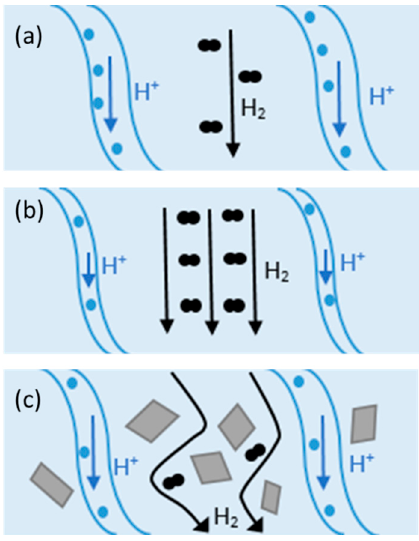
Figure 3. ( a ) Hydrogen and proton transport through Nafion at 80 °C ( b ) Hydrogen and proton transport through Nafion at higher temperatures ( c ) Hydrogen and proton transport through Nafion composite at higher temperatures.